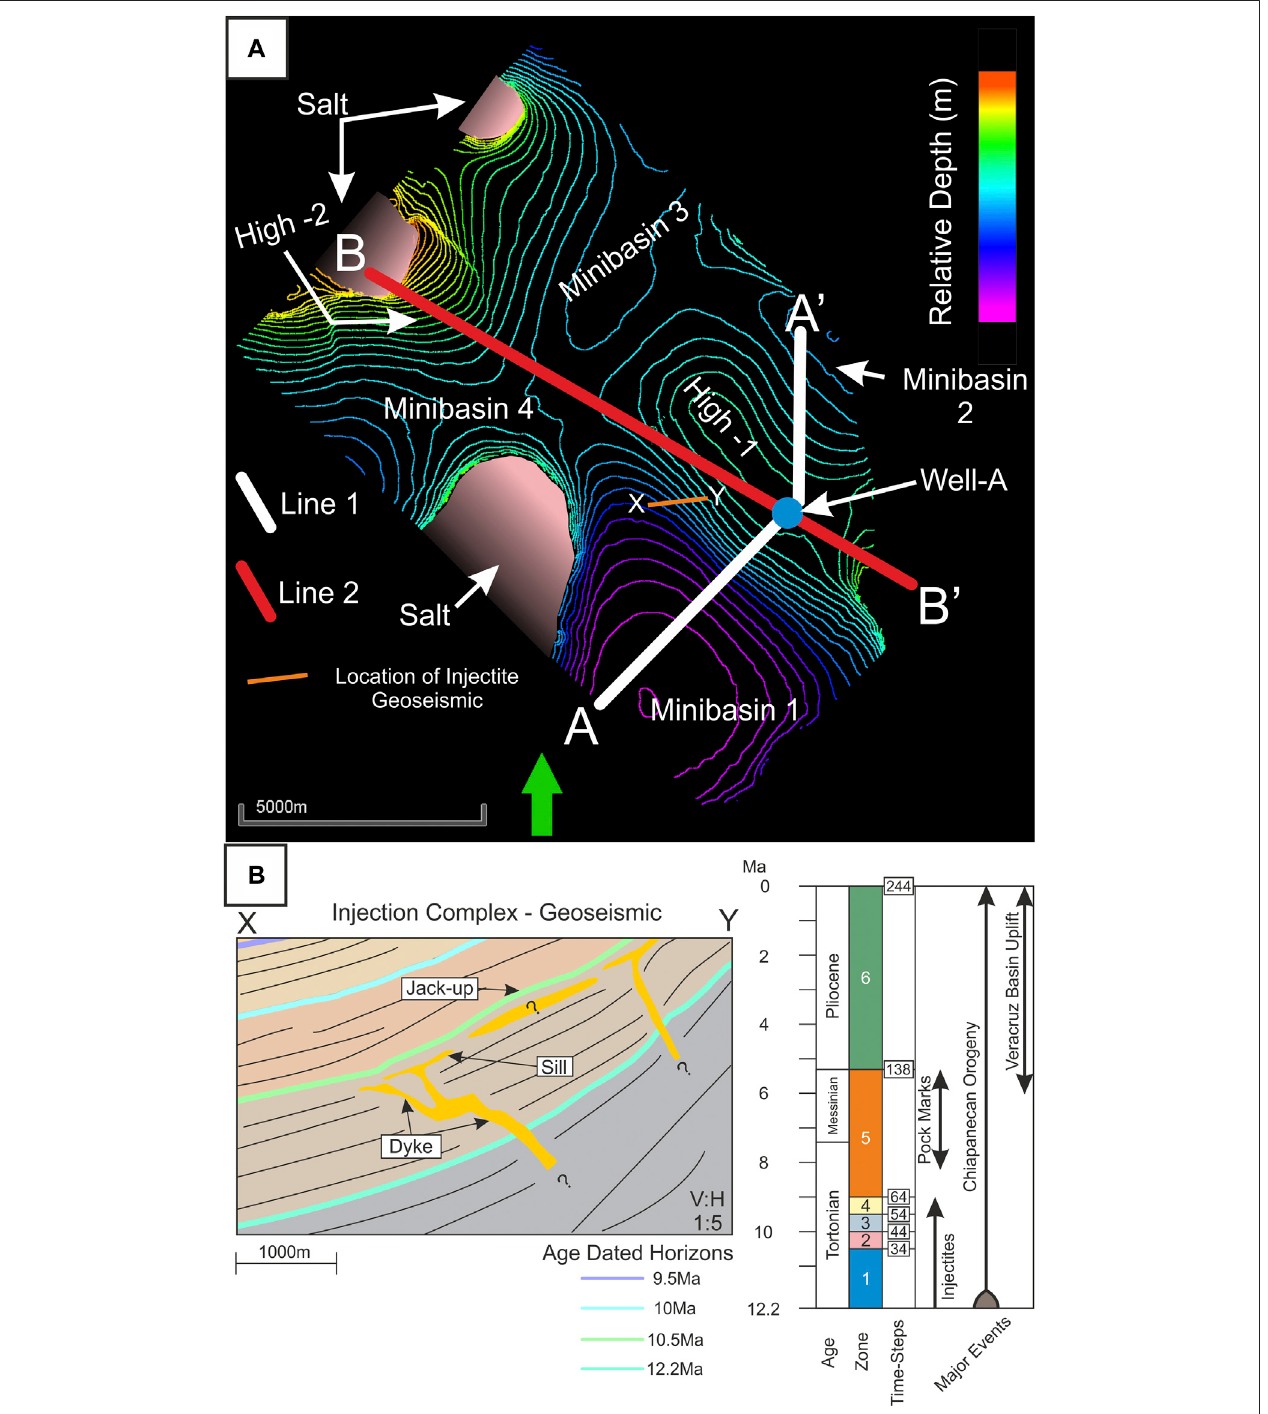
FIGURE 2| (A) Location of Well-A superimposed over arelativedepth map of the 12.2 Ma horizon interpretation, and the two modelled cross-sections Line 1 and Line 2. Frame of reference has been rotated to preserve con fi dentiality. (B) Geoseismic section X-Y, located to the southwest of High-1, showing a sand injectite dyke and sill complex within Lower Tortonian section. The interpreted timing of sand injection shown on the stratigraphic chart is based on observed sediment response to local sea fl oor uplift (jack-up above injectite sills). Pockmarks in the overlying Upper Tortonian to Messinian section indicate a second pulse of fl uid- fl ow.